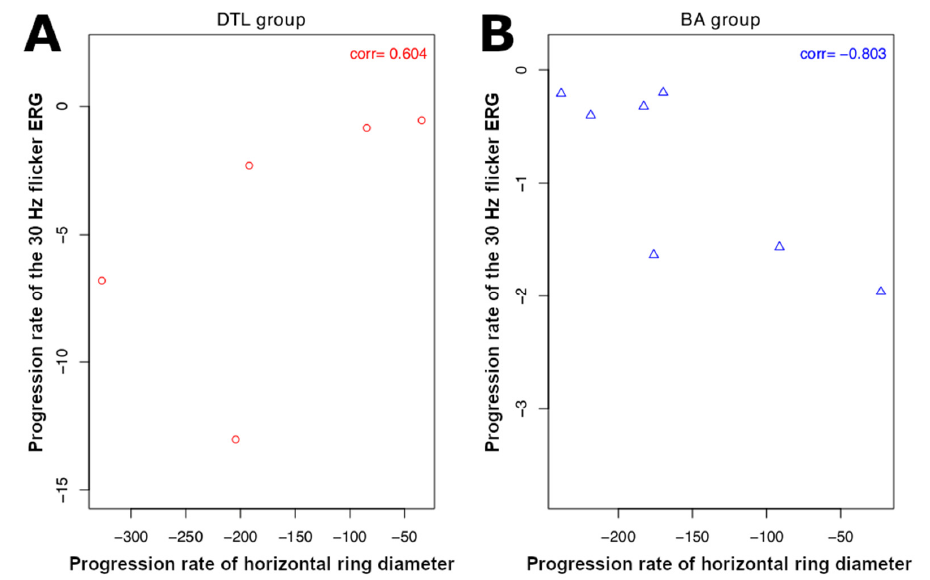
Figure 2. Scatter plot of the progression rate of 30 Hz flicker electroretinogram (ERG) amplitude versus that of horizontal ring diameter: ( A ) progression rates of patients in DTL and ( B ) BA groups. Correlation between progression rates is not significant in DTL group, while in BA group significant negative correlation ( − 0.803) is observed. Here 'corr' at the top-right corner of each subplot denotes correlation coefficient.